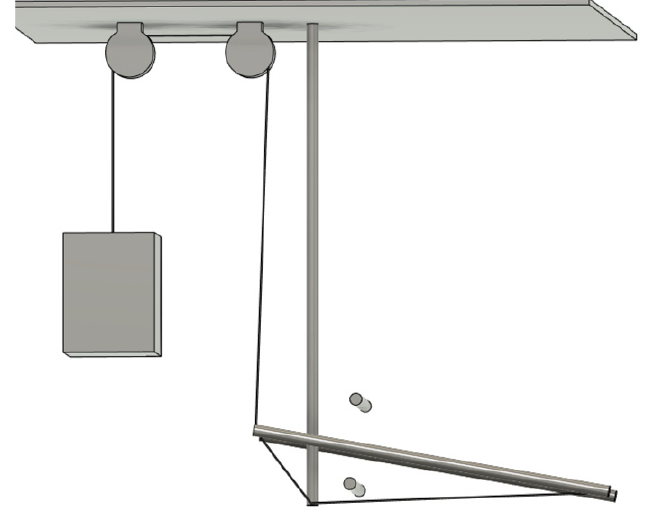
Figure 12. The path of the pulley string in the downward movement. The string is passed from the tip to the end of the compression material on the elbow side of the upper arm, and then to the end of the compression material on the elbow side of the lower